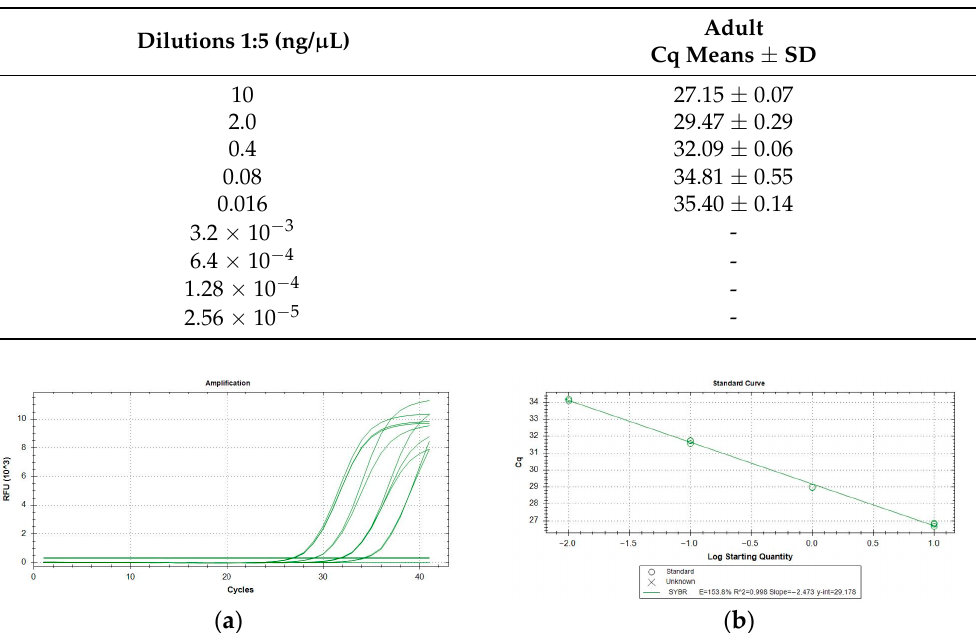
Table 2. P. italosignus analytical sensitivity (LoD) assays using 1:5 serial dilutions (from 10 ng/µL to 25.6 fg/µL). The Cq values are the mean of the three threshold cycles of each dilution; Cq values above 35 were considered negative results.